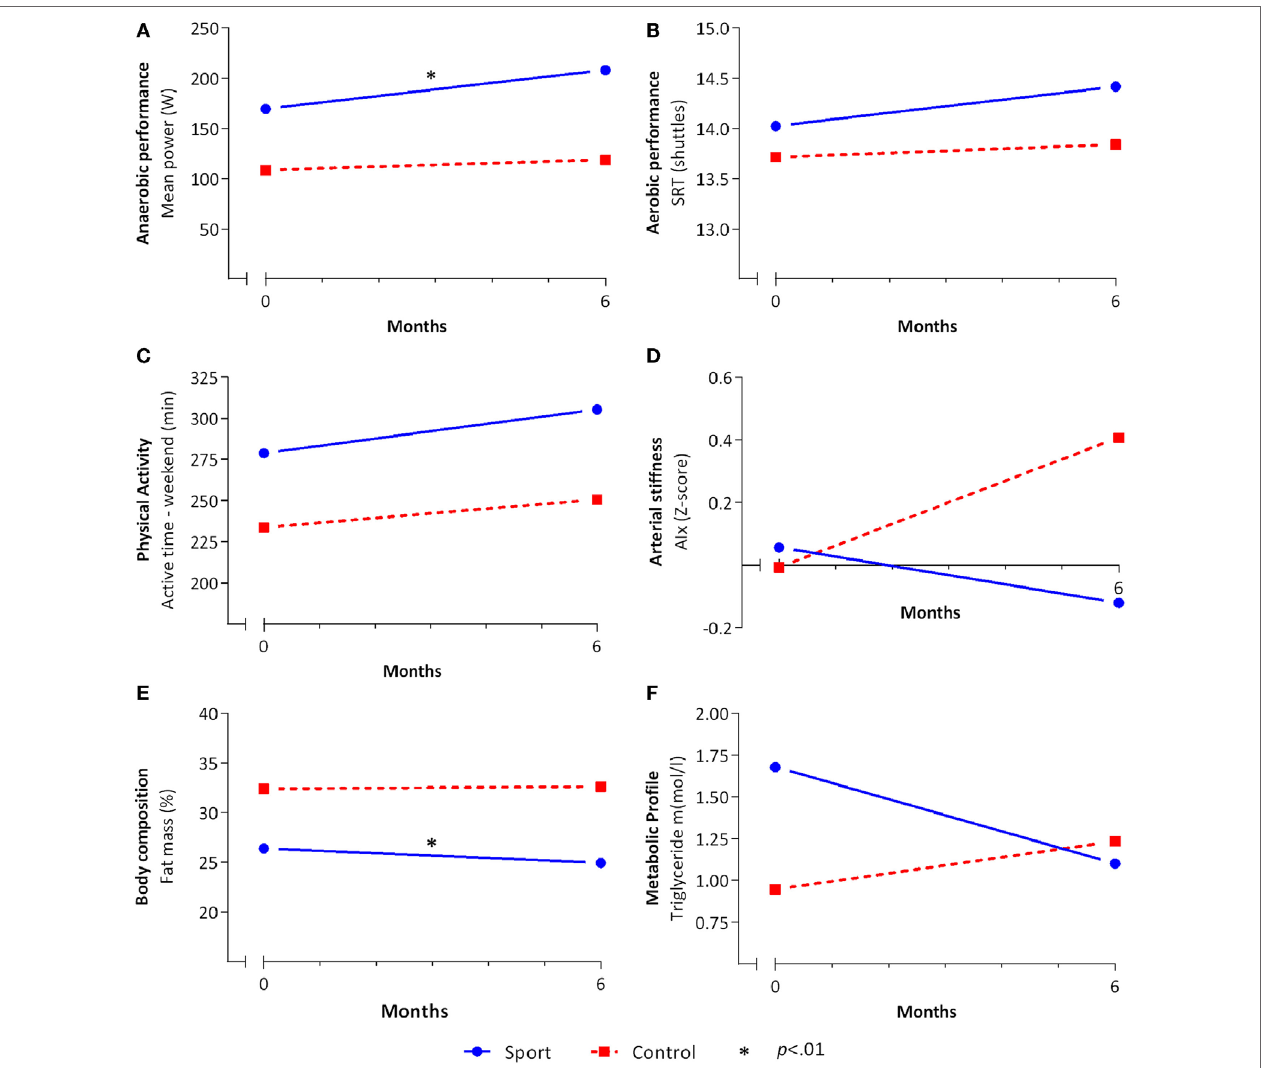
FigUrE 2 | Effects of the school-based once-a-week sports program. The mean values for the sport (solid blue line) and control (dashed red line) group before ( T 1) and after ( T 2) the school-based sports program of (a) anaerobic performance, (B) aerobic performance, (C) physical activity, (D) arterial stiffness, (E) body composition, and (F) metabolic profile on the multiple-imputed model. Linear regression analyses were done on the multiple-imputed model adjusted for T 1. *Significant ( p < 0.01) effect in favor of the sport